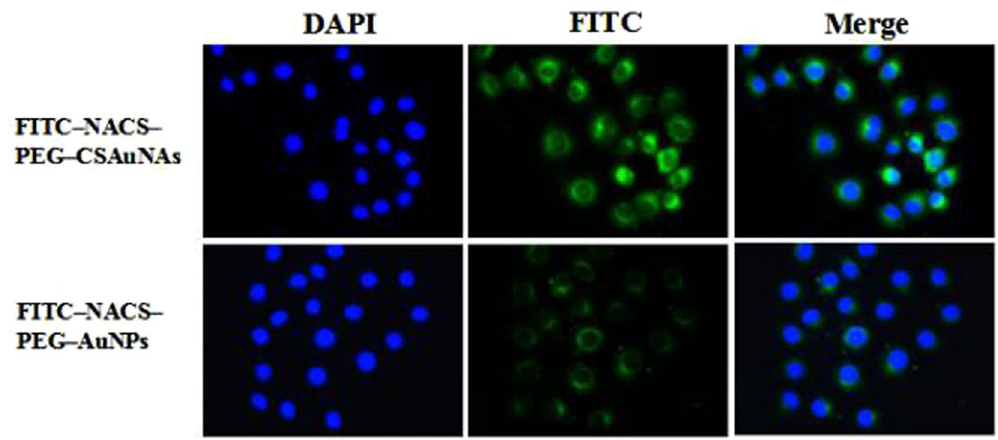
Figure 7. Comparison of cellular uptake of F ITC-NACS-PEG-CSAuNAs and